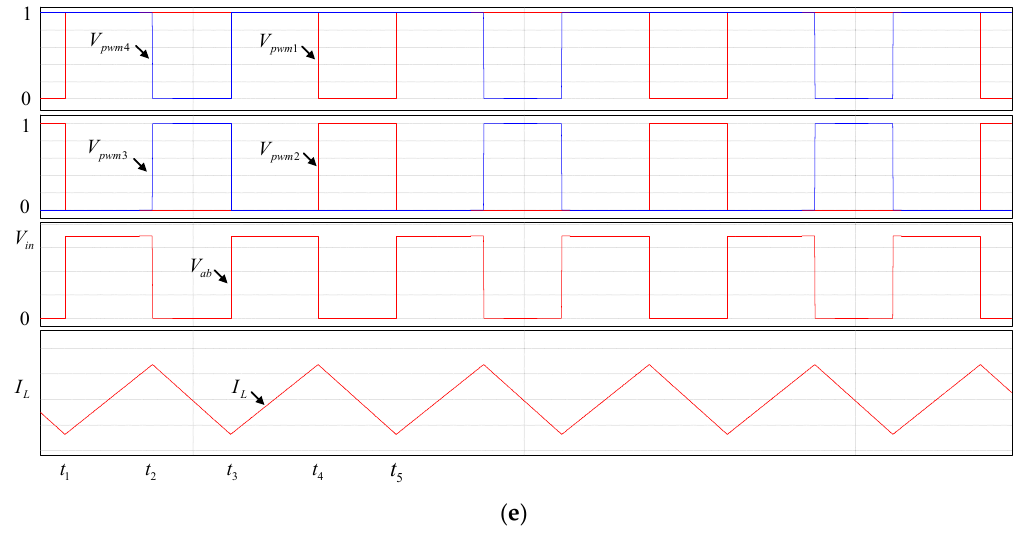
Figure 3. Power flow and related waveforms in buck mode. ( a ) Power flow in Mode I. ( b ) Power flow in Mode II. ( c ) Power flow in Mode III. ( d ) Power flow in Mode IV. ( e ) Related waveforms during buck mode.